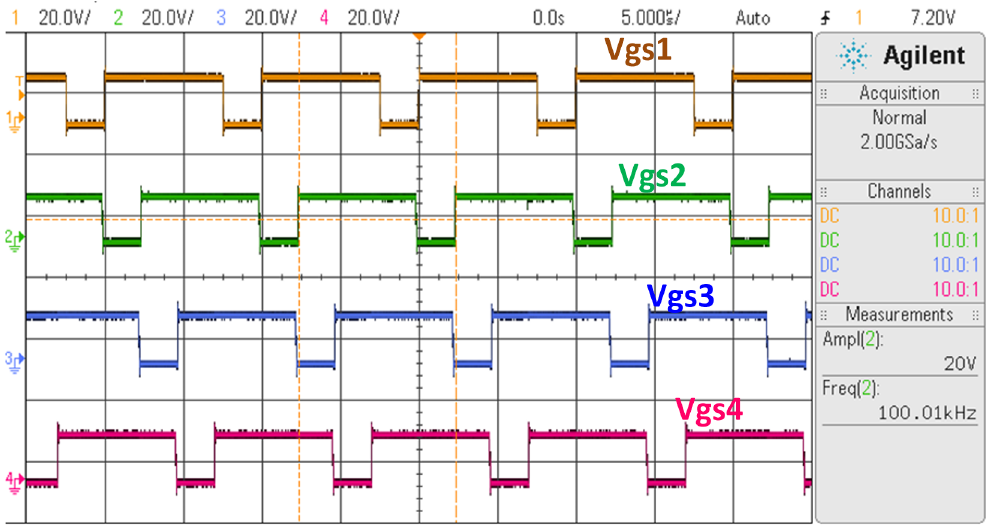
Figure 16. Switching gate-source voltages: Brown—switch 1, Green—switch 2, Blue—switch 3, Violet—switch 4.